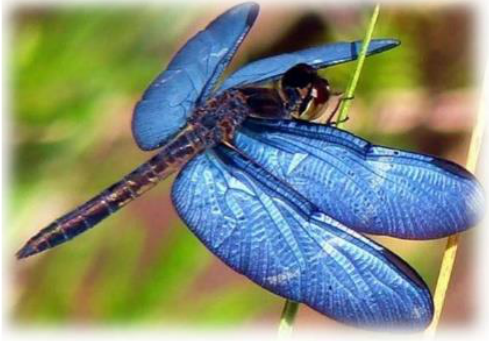
Figure 4. Real dragonfly .